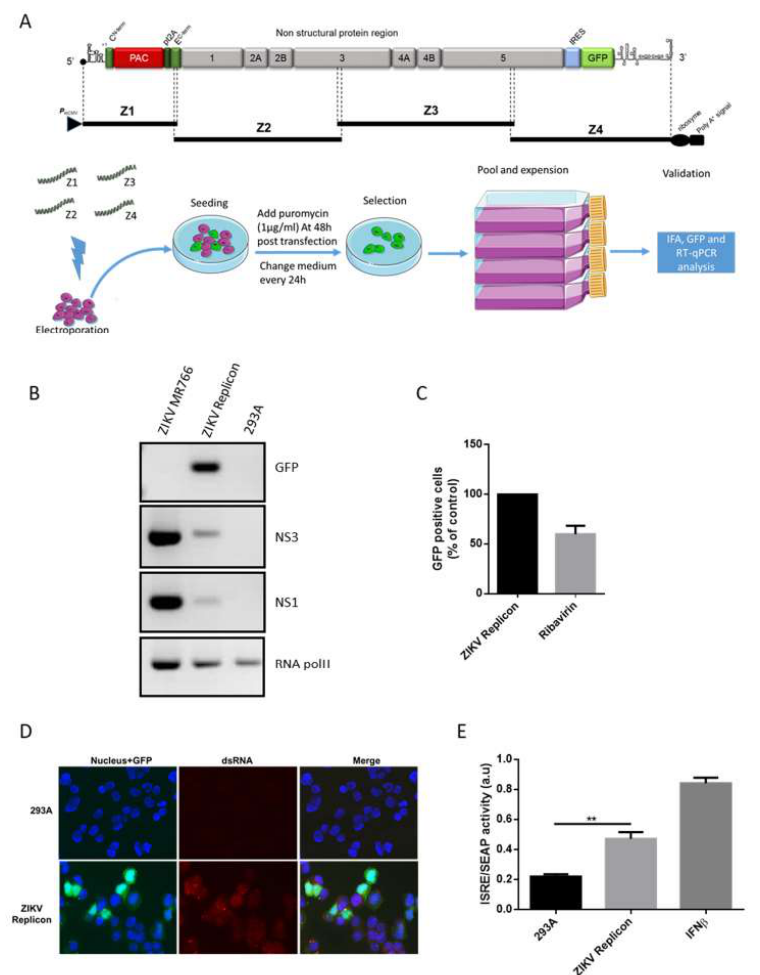
Figure 1. Generation and validation of ZIKA Virus (ZIKV) replicon in HEK-293A cells. ( A ) Schematic representation of overlapping fragments Z1 to Z4 covering of ZIKV replicon. Below, the flow chart representing the design of the experiment. ( B ) GFP, ZIKV NS3, ZIKV NS1 and RNA pol-II mRNA expression assessed by RT-PCR in ZIKV-infected A549 cells, ZIKV replicon cells and HEK 293A cells. ( C ) Cytometry monitoring of GFP after ribavirin treatment. ( D ) Fluorescence microscopy images of ZIKV replicon cells (GFP positive) after immunostaining of dsRNA with J2 antibody (red). ( E ) ISRE/SEAP activity evaluated in HEK 293A cells and ZIKV replicon cells. As positive control, cells were treated for 24 h with recombinant IFN- β (10,000 UI · mL − 1 ). ** p <